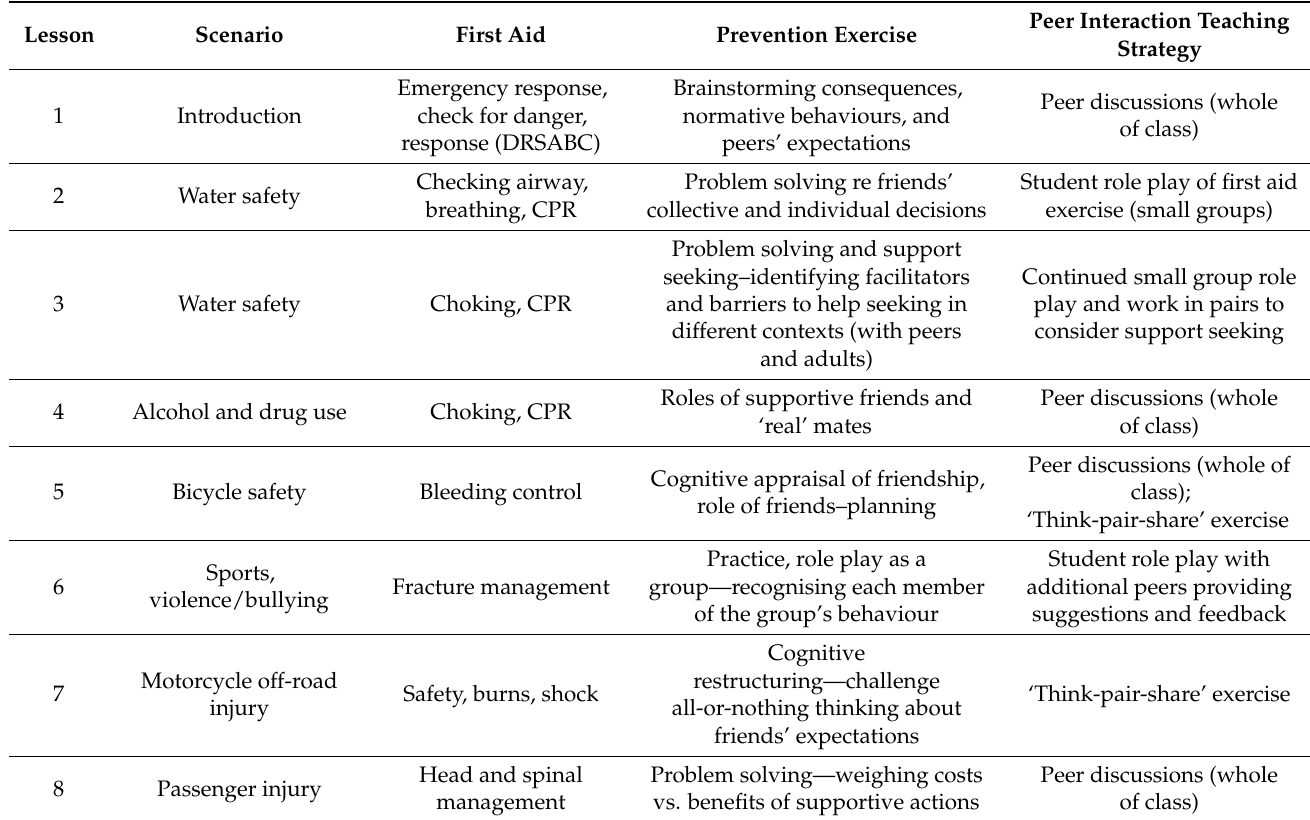
Table 1. Outline of the Scenario-based learning activity, first aid component, prevention exercise, and peer-delivery strategy.